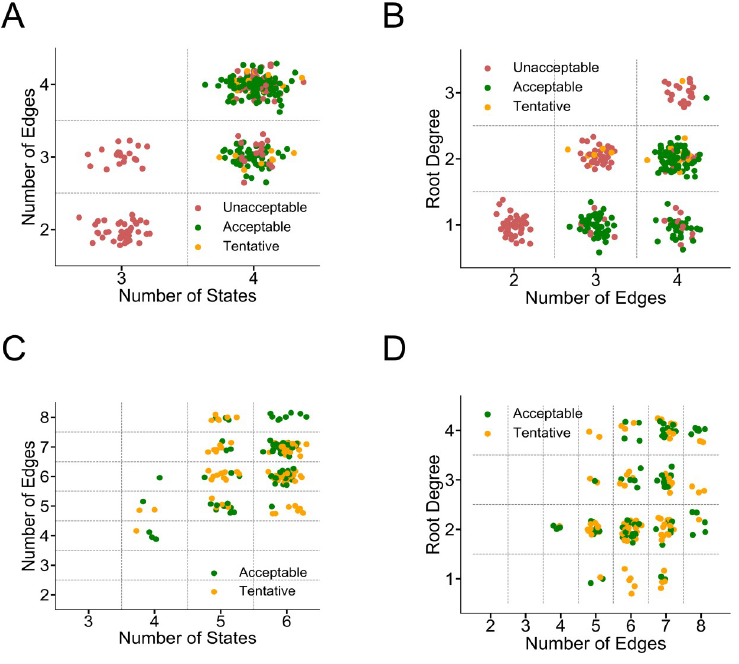
Fig 4. Summary of Markov model performance for all topologies studied. A) and B) Performance summary of all